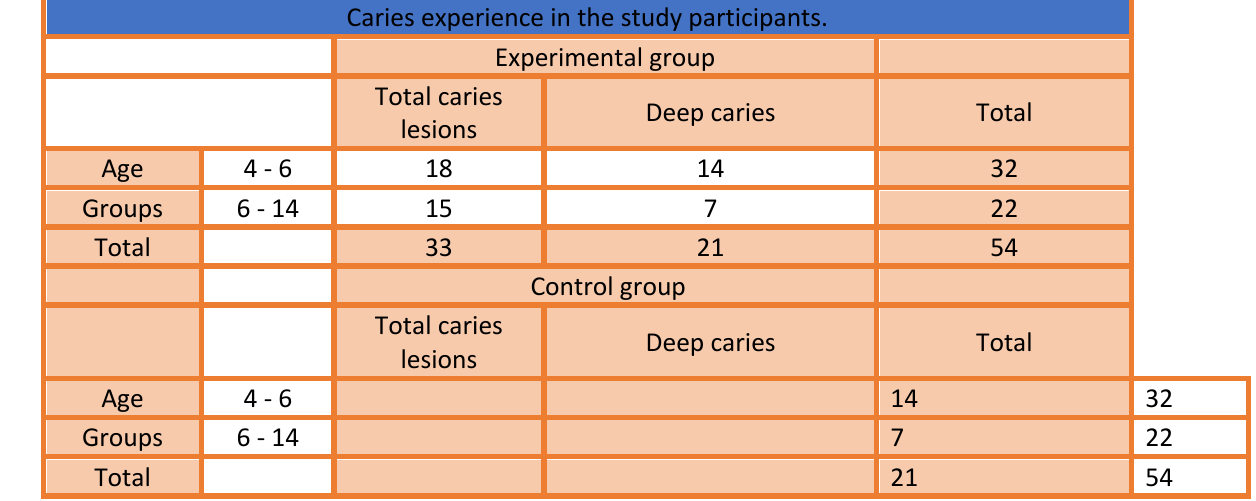
Table 1: Age and diagnosis of